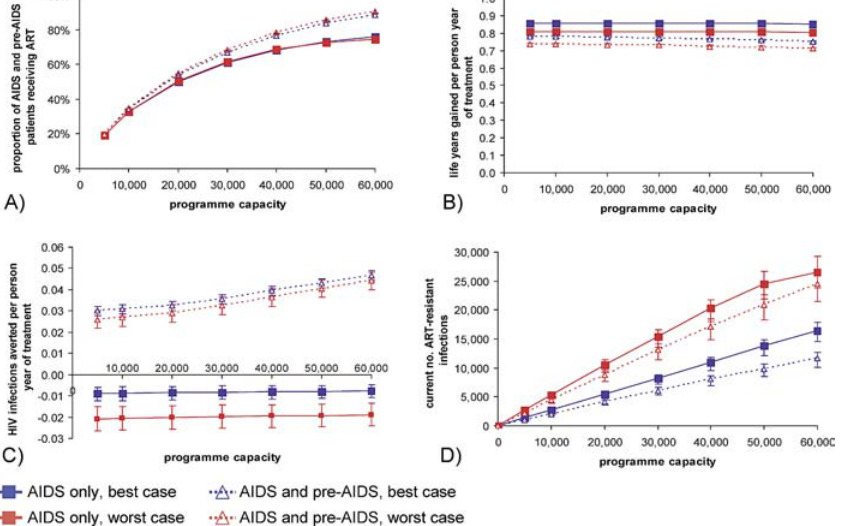
Figure 4. Effect of Programme